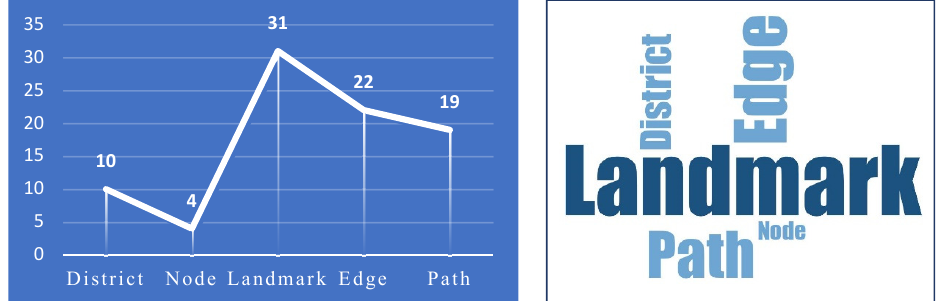
Figure 7. Frequency of identified codes, and the most significant elements influencing subjective legibility using the word cloud processor of the MAXQDA software.